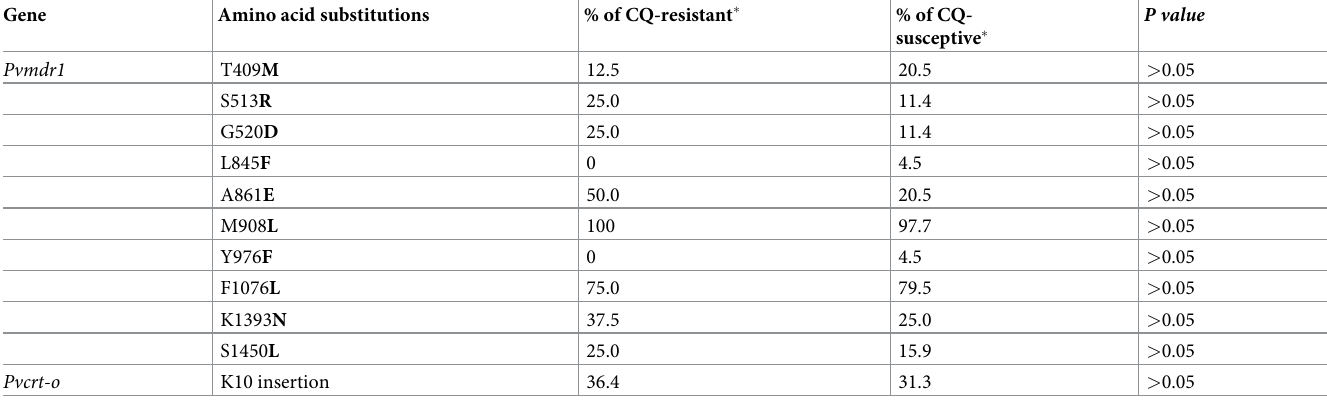
Table 4. Comparison of pvmdr1 and pvcrt-o substitutions between chloroquine sensitive and -resistant isolates. Gene Amino acid substitutions % of CQ-resistant � % of CQ-